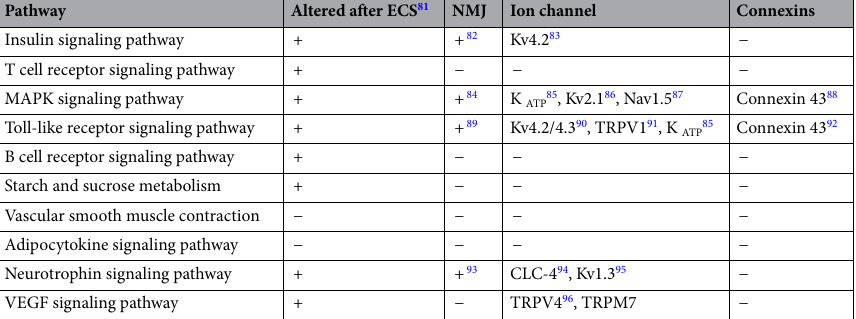
Table 9. The regulation of KEGG pathways enriched by den-genes on muscle components. NMJ neuromuscular junction, ECS electrical Stimulation, CLC-4 chloride channel 4, TRPV4 transient receptor potential vanilloid 4, TRPM7 transient receptor potential melastatin-subfamily